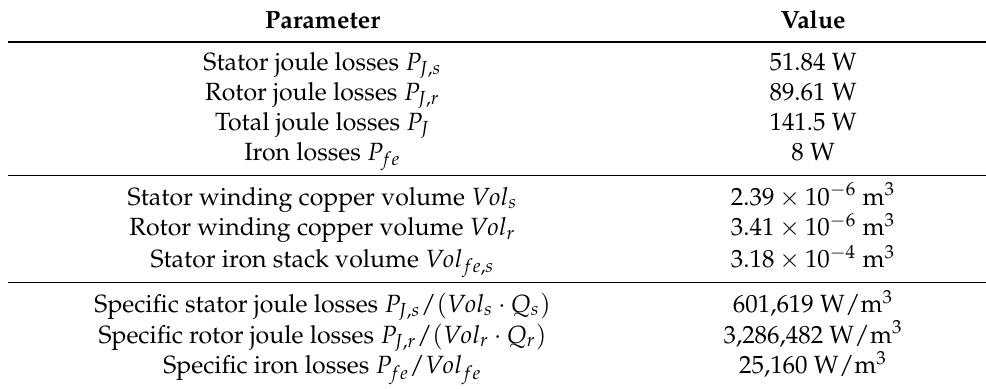
Table 7. Power losses and specific losses of the eight-pole HE-IPM at the rated speed ω B = 1010 r/min.